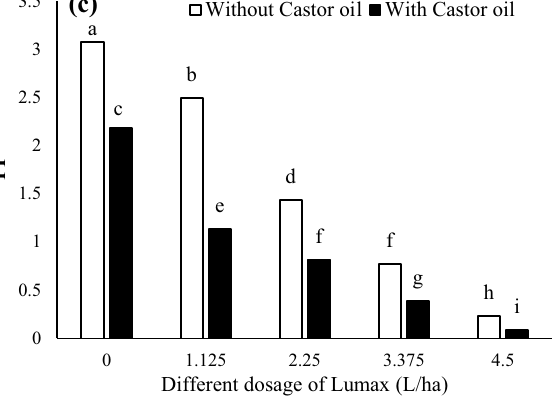
Figure 7. Changes in Fv/Fm ( a ), Fv/F0 ( b ), and PI ( c ) of Solanum nigrum in response to different doses of Mesotrion + S-metolacholor + Terbuthylazine with and without Castor oil. Each value is the mean of four replicates. Different letters represent significant differences ( P <